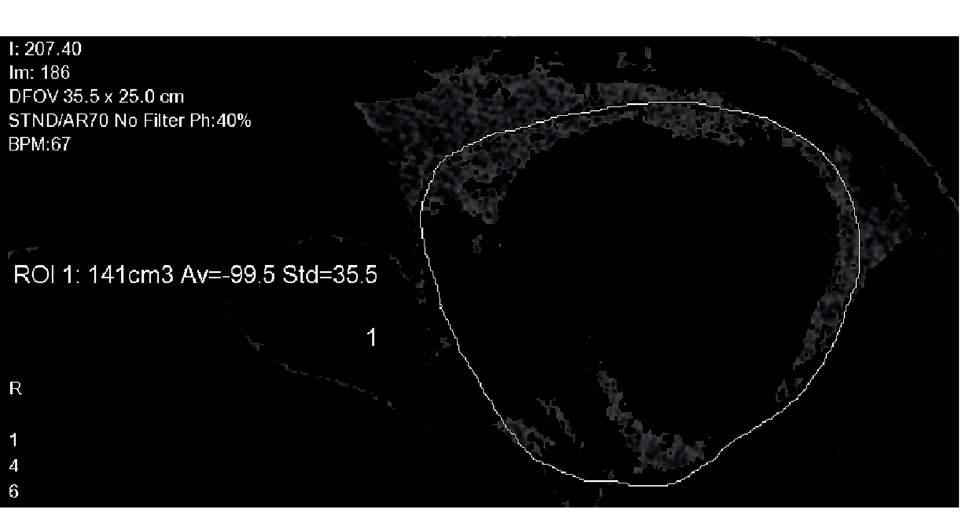
Figure 3. EAT measurement: contouring of the fibrous pericardium.